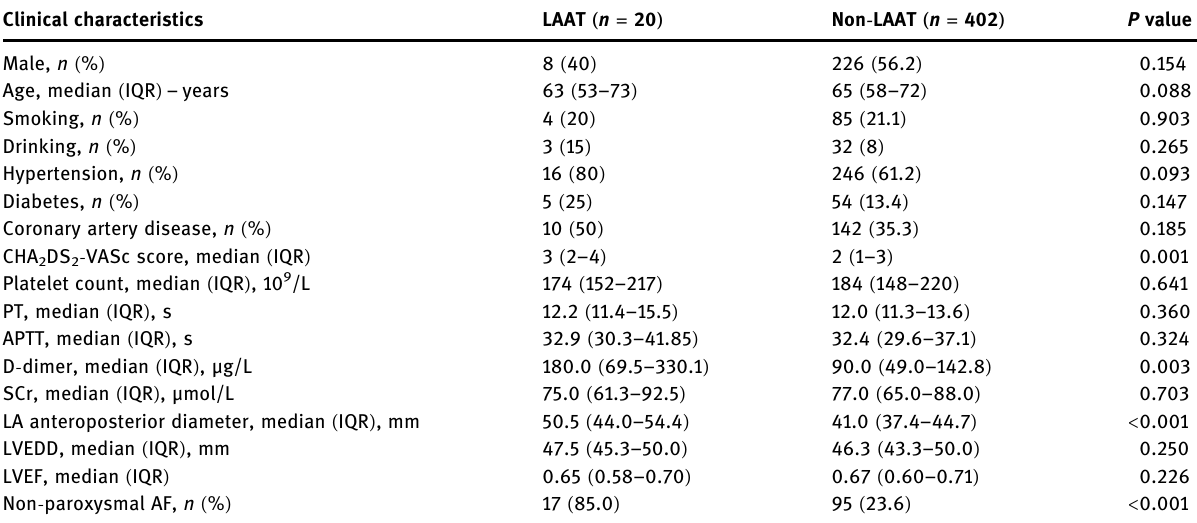
Table 1: Comparisons of baseline characteristics between LAAT and non - LAAT groups Clinical characteristics